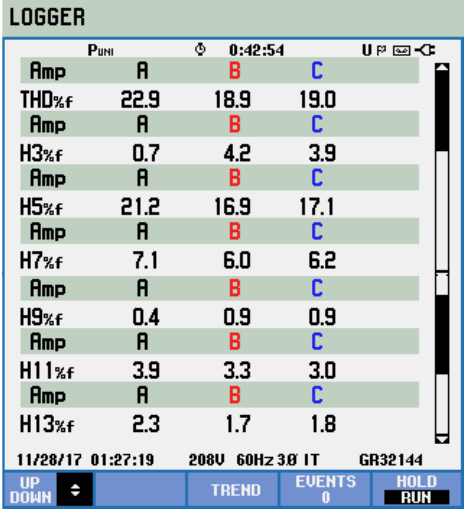
Figure 9. Three-phase grid current harmonic components with the DHPF-NSI disabled.